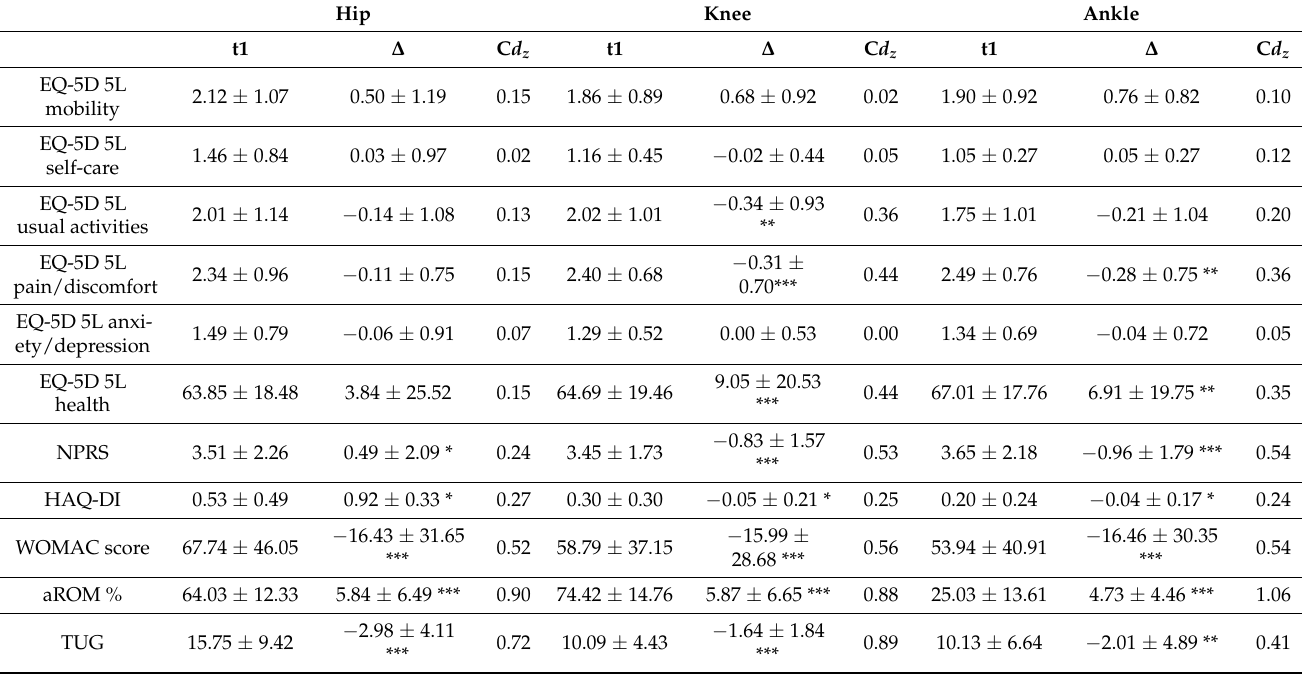
Table 2. PROMs and CROMs at baseline (t1), changes (t2 − t1, ∆ ) and effect sizes (Cohen’s d z ) for all three